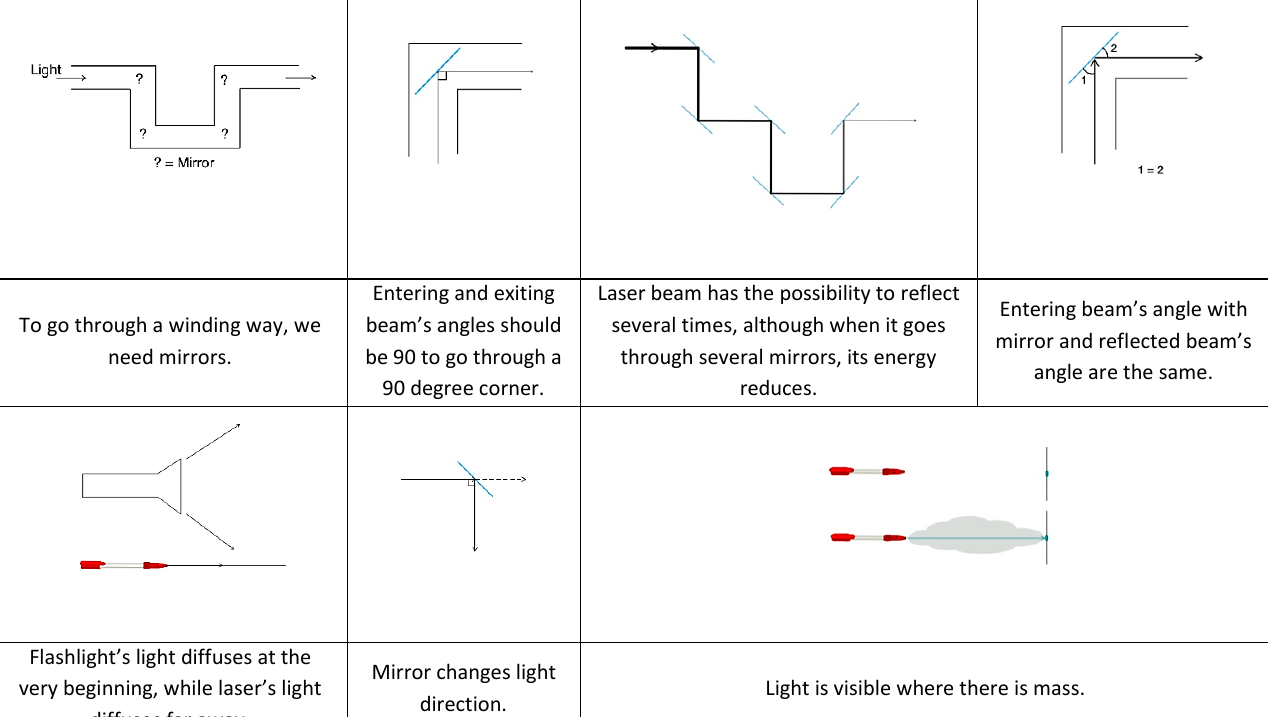
Figure 14 Learning content about light, mirror and reflection revealed in the questioner